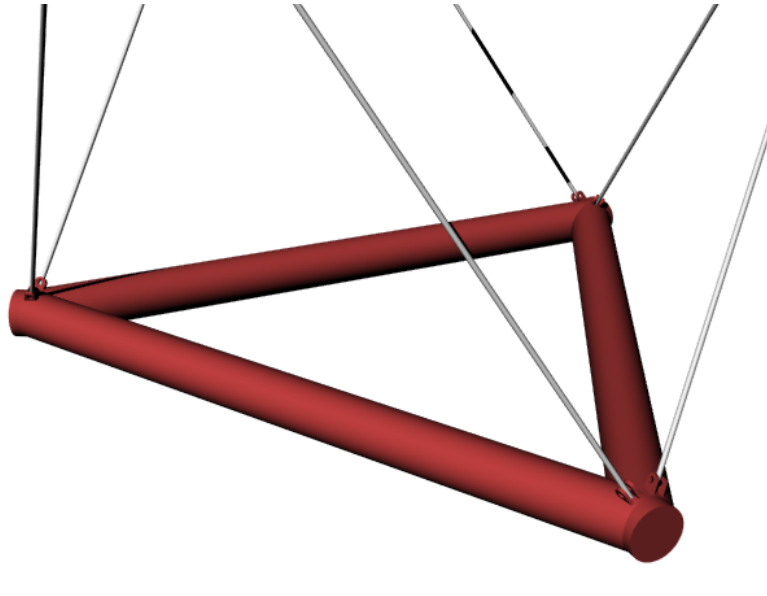
Figure 5. Illustration of the